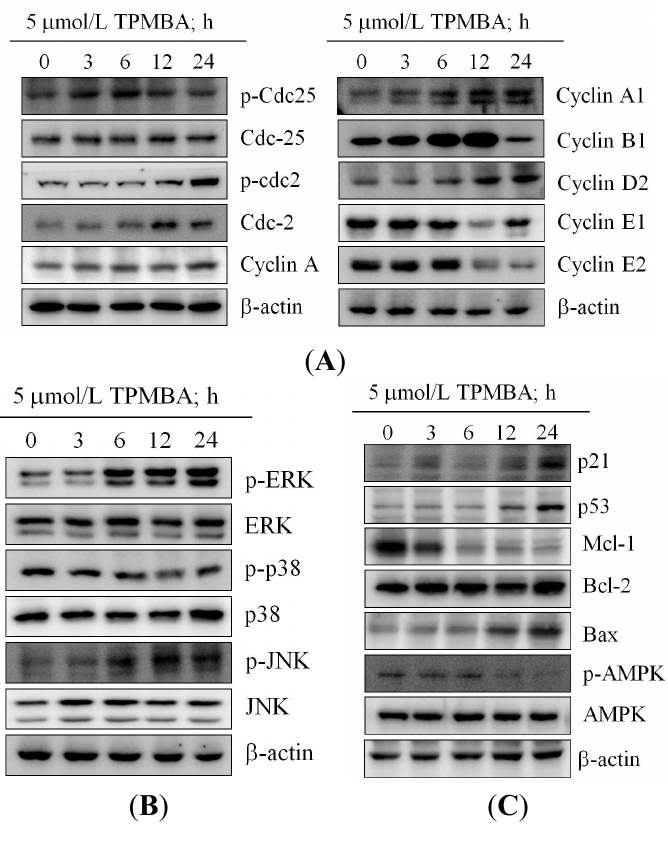
Figure 5. Western blot analysis of the time-dependent modification effects of TMPBA on the expression and/or phosphorylation. MCF-7 Cells were exposed to 5 µM TMPBA in 10% FBS-supplemented DMEM for the indicated time intervals. ( A ) The effect of TMPBA on MAP kinases ERK1/2, JNK and p38 activation was investigated in MCF-7 cells; ( B ) Regulation of cell cycle-regulatory proteins by TMPBA, including cdc2, cdc25, cyclin A, cyclin A1, cyclin B1, cyclin D2, cyclin E1, cyclin E2, was determined by Western blotting; ( C ) Apoptosis-associated proteins p21, p53, MCl-1 Bcl-2, Bax, and AMPK were evaluated in TMPBA-induced cell